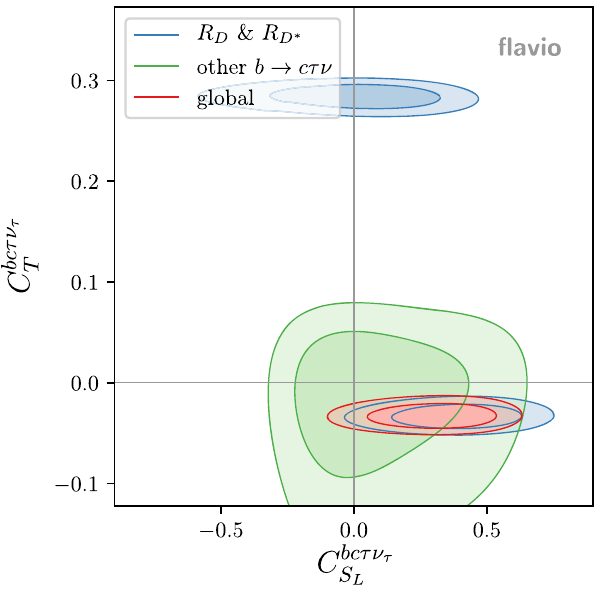
Fig. 3 Left: likelihood contours in the space of the b → c τν τ WET scalaroperatorsfrom R D and R D ∗ (blue),thecombinationof B c → τν , B → D ( ∗ ) τν differential rates and F L ( B → D ∗ τν) (green) and the global likelihood (red). Right: likelihood contours for the SMEFT